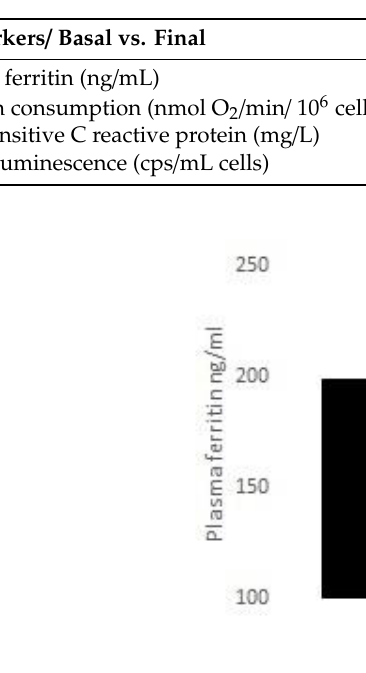
Table 6. Variables of the inflammatory state; in plasma: ferritin and US CRP, and in neutrophils: baseline and post-treatment (after 90 days of resveratrol, piperine y alpha-tocopherol) oxygen consumption and chemiluminescence.